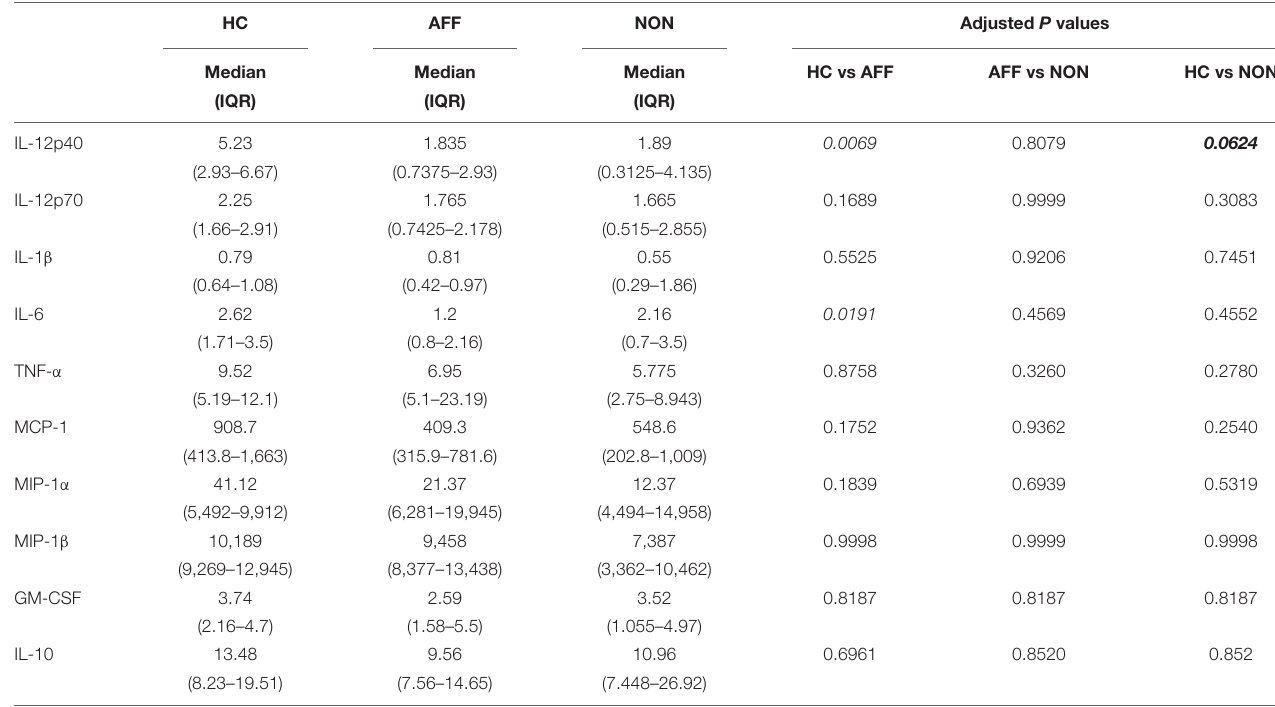
TABLE 2 | Concentration of cytokines/chemokines at baseline (media